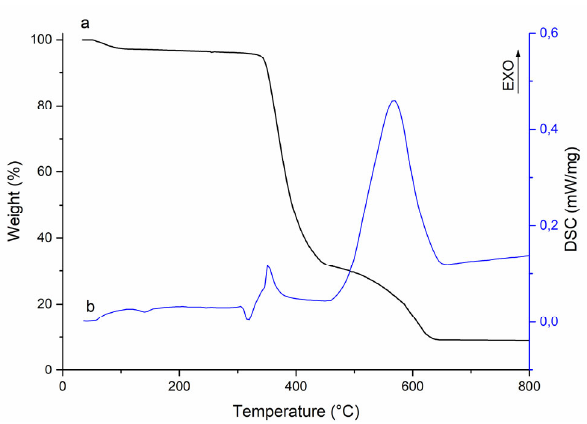
Figure 3. TGA (a) and DSC (b) curves of poly(VT- co -VK) copolymers (for example P3).